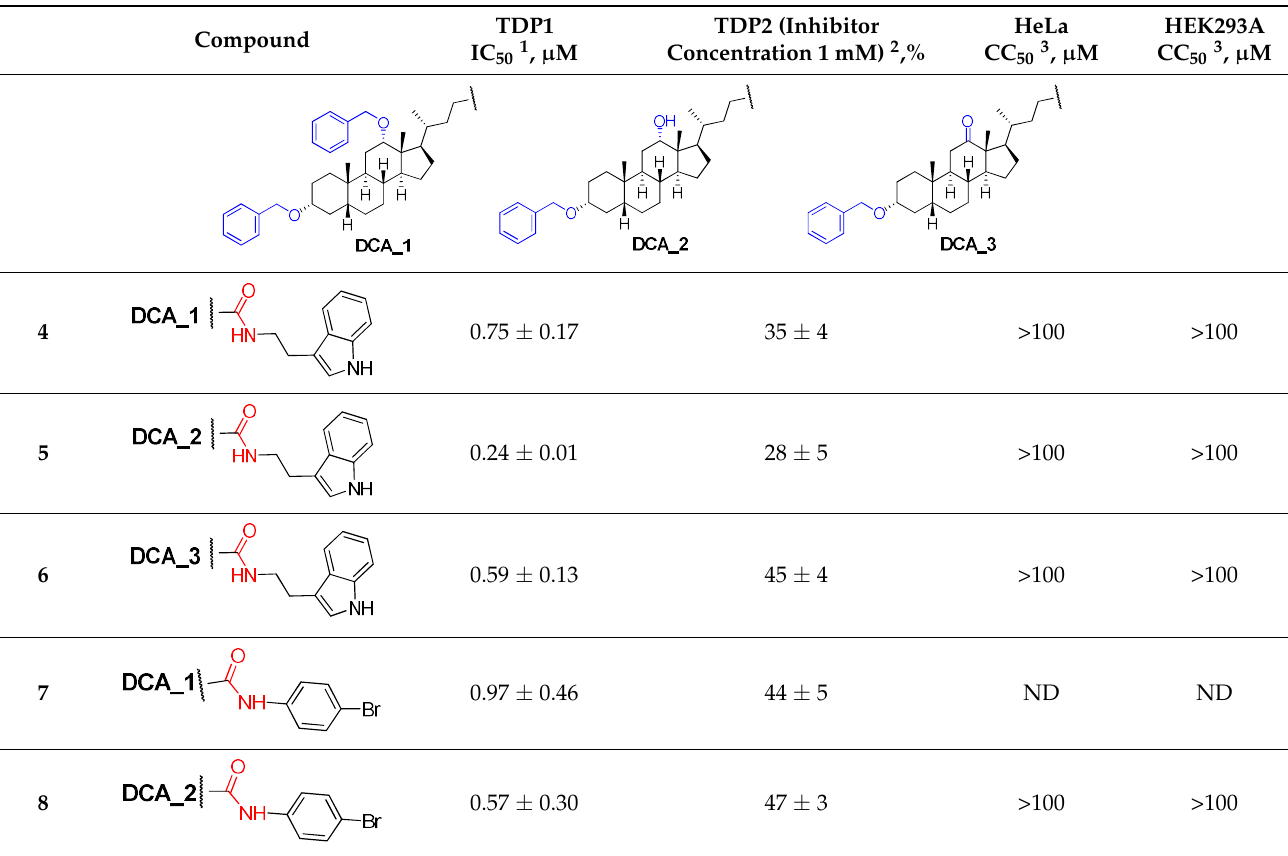
Table 1. TDP1 and TDP2 inhibitory activity of compounds 1 – 18 .